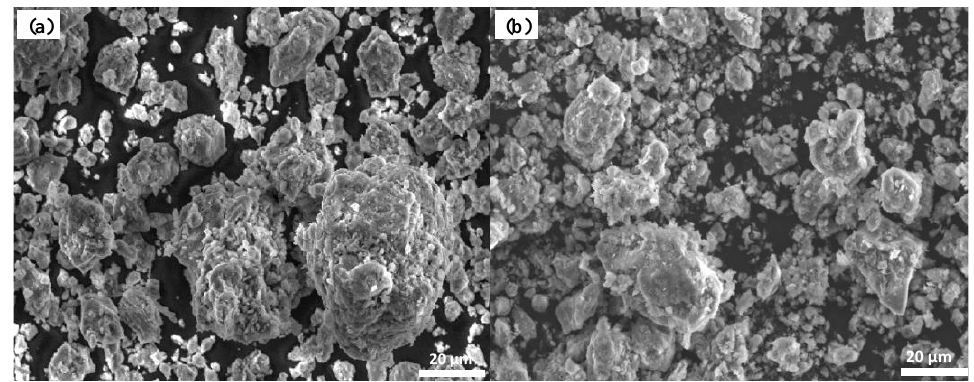
Figure 3. SEM micrographs of: ( a ) raw dry sieved and ( b ) wet sieved bentonite samples at 20 µm. SEM micrographs of wet sieved bentonite and Na 2 CO 3 -modified samples, in the concentrations of 2 wt.%, 4 wt.%, and 6 wt.% Na 2 CO 3 are shown in Figure 4. As can be seen